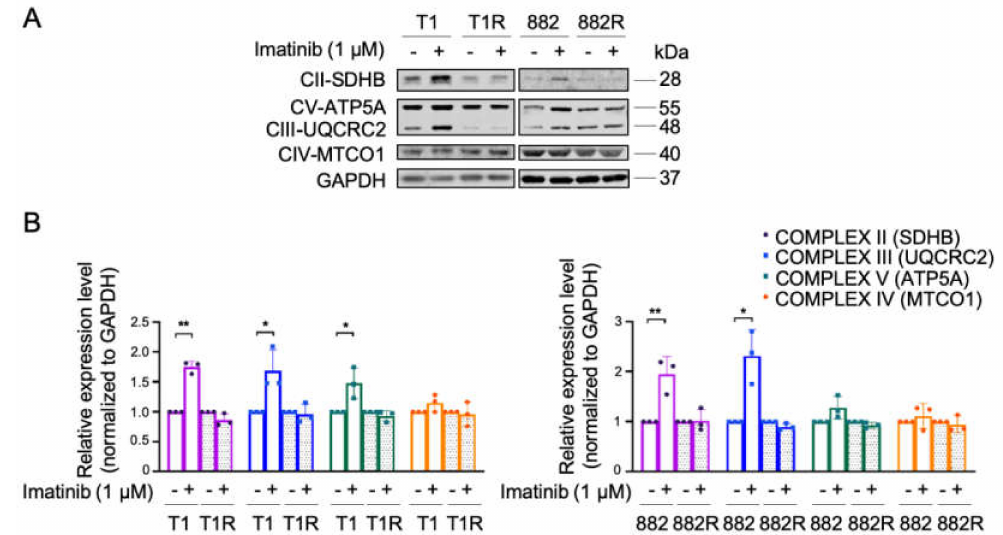
Figure 1. Expressions of glycolysis and oxidative phosphorylation (OXPHOS) proteins in imatinib-sensitive and imatinib-resistant gastrointestional stromal tumors (GIST) cell lines treated with or without 1 µ M of imatinib for 48 h. ( A ) Representative immunoblots of OXPHOS proteins are shown. Estimated protein sizes are given to the right in kiloDalton (kDa). ( B ) The quantification of OXPHOS protein expression levels was analyzed from 3 independent biological experiments. Glyceraldehyde 3-phosphate dehydrogenase (GAPDH) was used as an endogenous loading control. Histograms represent mean ± SD. * p < 0.05, ** p < 0.01 (Student’s t